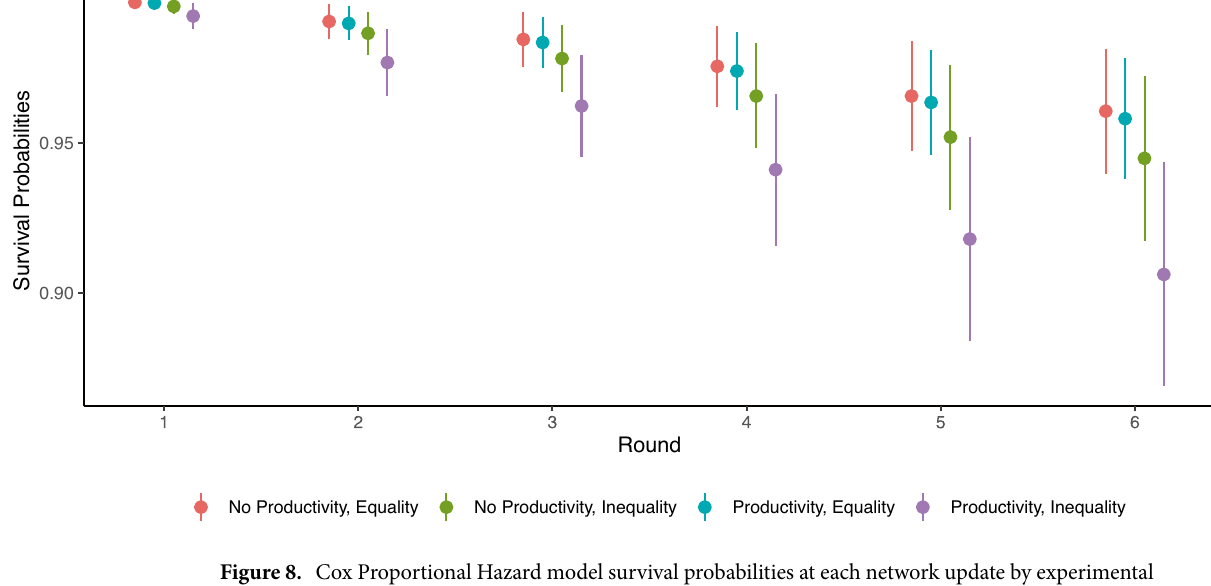
Figure 8. Cox Proportional Hazard model survival probabilities at each network update by experimental condition. Participant endowments and cooperation (time-varying covariates) are set to their